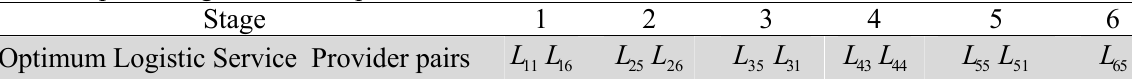
Pairs of optimal logistic service providers